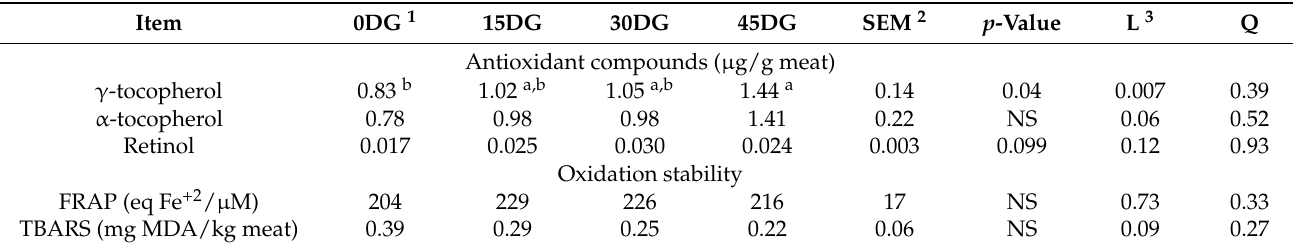
Table 3. Content of antioxidant vitamins and oxidation stability in fresh meat samples (LTL) muscle at 72 h